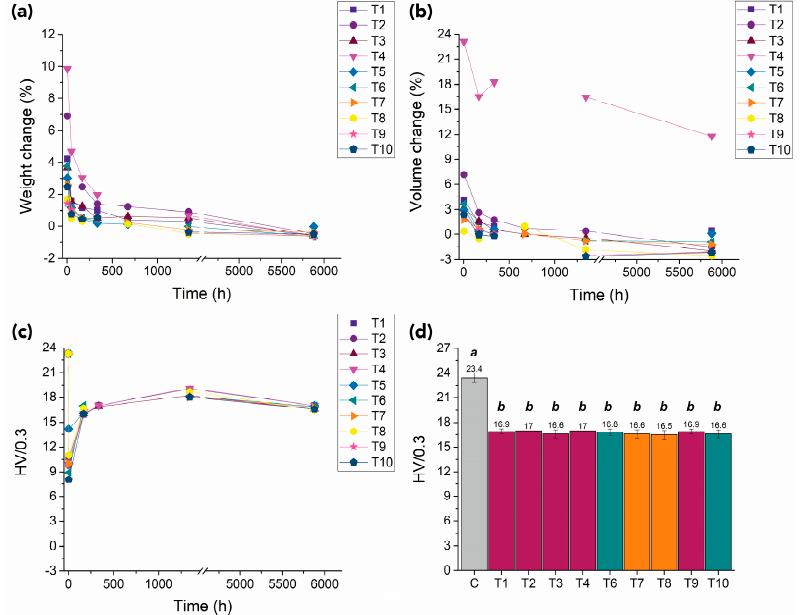
Figure 8. Summary of changes over time (up to 35 weeks, i.e., ~6000 h) in ( a ) weight, ( b ) volume, and ( c ) mean Vickers hardness values for PMMA samples exposed to CO 2 under different conditions. ( d ) Vickers hardness values (average and standard deviation) after 35 weeks for a control, an untreated sample (gray bar labeled C), and CO 2 -exposed samples (colored bars T1–T10) at different conditions (supercritical: purple bars; liquid: blue bars; vapor: orange bars). Statistical significance for ANOVA and Tukey–Kramer multiple comparison tests was established at a p -value < 0.05. Mean values that do not share a letter are significantly different and vice versa.